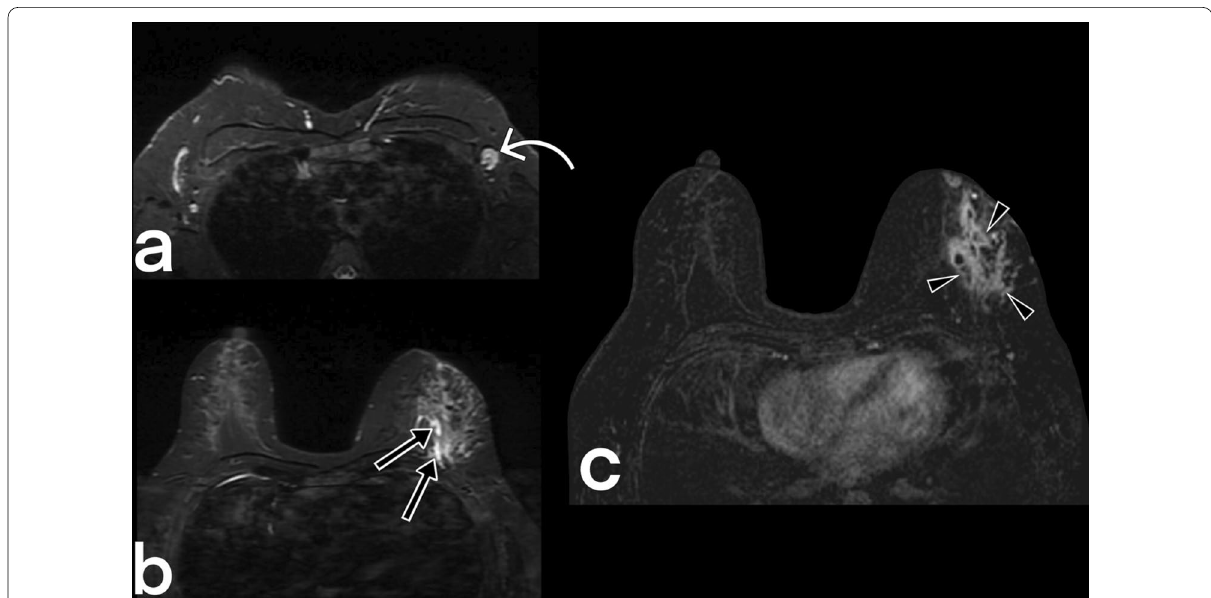
Fig. 13 MR images of a 32-year-old female. Axial T2-weighted fat-suppressed ( a , b ) and T1-weighted fat-suppressed contrast-enhanced images ( c ) reveal a signal increase and heterogeneous non-mass enhancement with regional type distribution in the left breast (arrowheads), and abnormal axillary lymph nodes (curved arrow). Small fluid collections are also noted (arrows). BIRADS 4